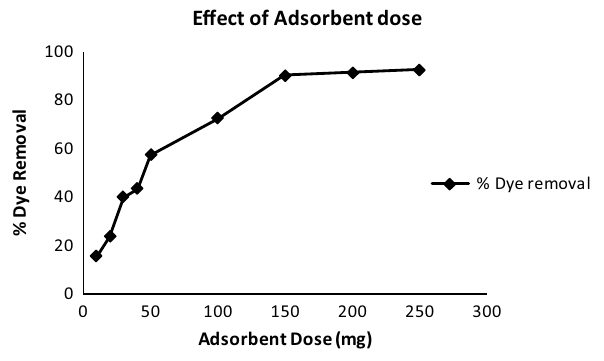
Fig. 10 Effect of adsorbent dose on CR dye removal. *Dye con-